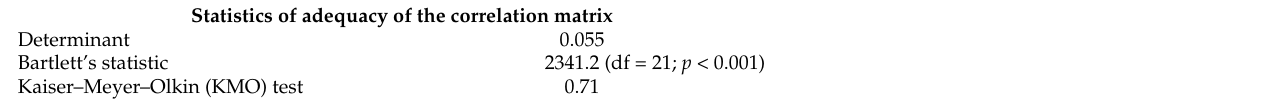
For the ISAC scale, the EFA began with seven items. The statistics evaluating the adequacy of the correlation matrix were satisfactory (Table 3). The Hull method sup- ported the presence of a single common factor. Only two items did not achieve target uni- dimensionality thresholds: “How difficult is it to talk to your primary partner about your current agreement?” (I-ECV = 0.23; I-REAL = 0.74); and “How fearful are you about